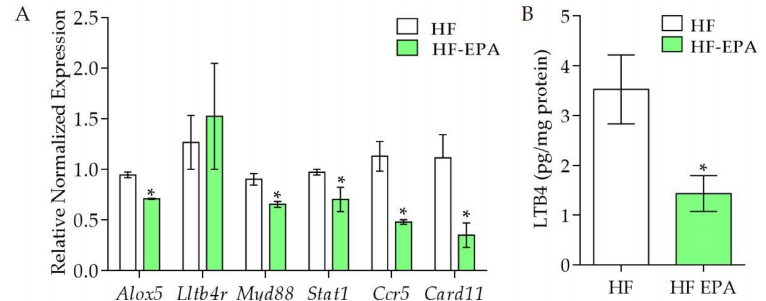
Figure 2. Validation of genes and LTB4 levels in adipose tissue from obese B6 mice. The expression of genes was validated by Q-PCR. ( A ) Gene expression of inflammatory markers Alox5 , Ltb4r , Myd88 , Stat1 , Ccr5 , and Card11 ; data are expressed as mean ± SEM, p ≤ 0.05, n = 6. ( B ) LTB4 levels in adipose tissue. Data are expressed as mean ± SEM, * p ≤ 0.05, n = 6; HF vs HF-EPA.